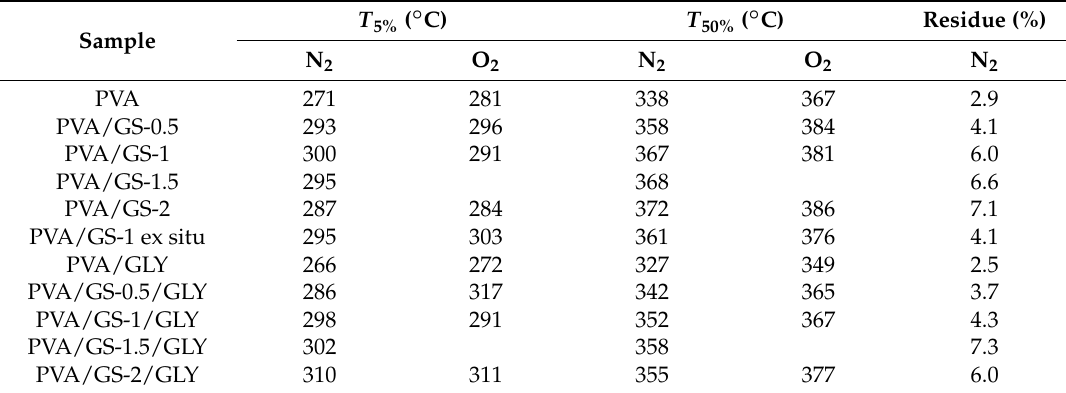
Table 2. TGA data for unplasticized and plasticized PVA and PVA/GS